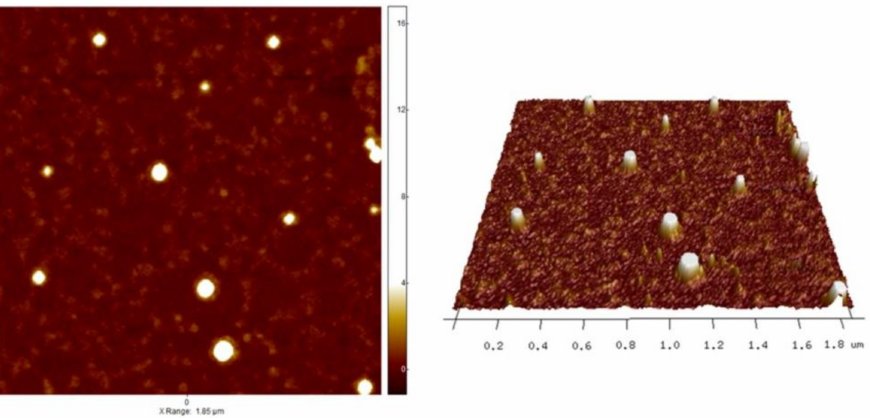
Figure 3. AFM image of LVAN in PBS pH 7.4. The image shows nano-sized particle and uniform distribution of the liposomal formulation.